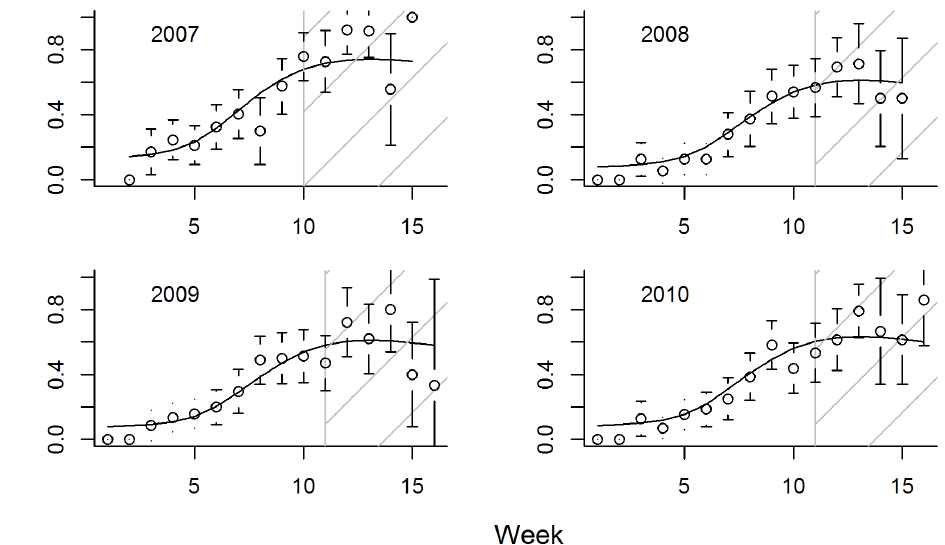
Figure 4. The probability that juvenile ring-necked ducks were observed on non-disturbed lakes. Non-disturbed lakes included all lakes . 5,000,000 m 2 in size, waterfowl refuges, and lakes . 100 m from a road with no boat access or house. Open circles correspond to observed proportions (with 95% confidence intervals) during falls of 2007–2010. Black lines give predictions from the ‘best-fit’ generalized estimating equation model (chosen using QIC). The gray vertical line (and hatched fill) demarcates the hunting season.